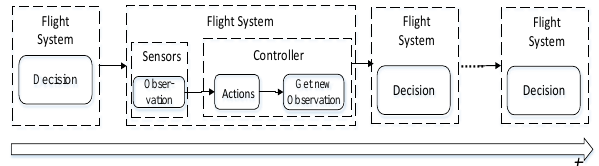
Figure 2. At each moment, the UAV sequential decision process can be divided into three steps: obtaining state information of the current system, performing actions, and updating the state.